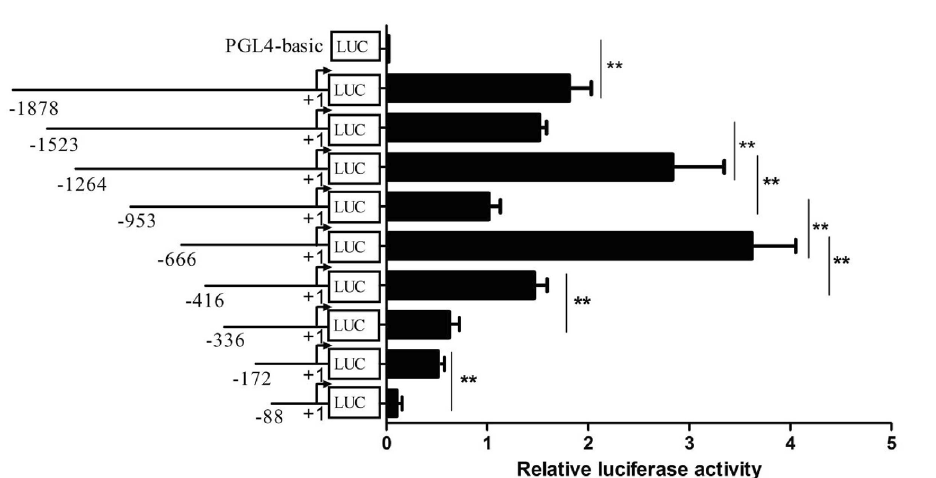
Figure 5. Luciferase activity of 5’-flanking fragment vectors of buffalo LPIN1 promoter in the BMECs. Relative luciferase activity (Firefly: Renilla) after 48 h transfection with different 5’-flanking deletion constructs (− 1878/ + 42 bp, − 1523/ + 42 bp, − 1264/ + 42 bp, − 953/ + 42 bp, − 666/ + 42 bp, − 416/ + 42 bp, − 336/ + 42 bp, − 172/ + 42 bp and − 88/ + 42 bp). **, P <